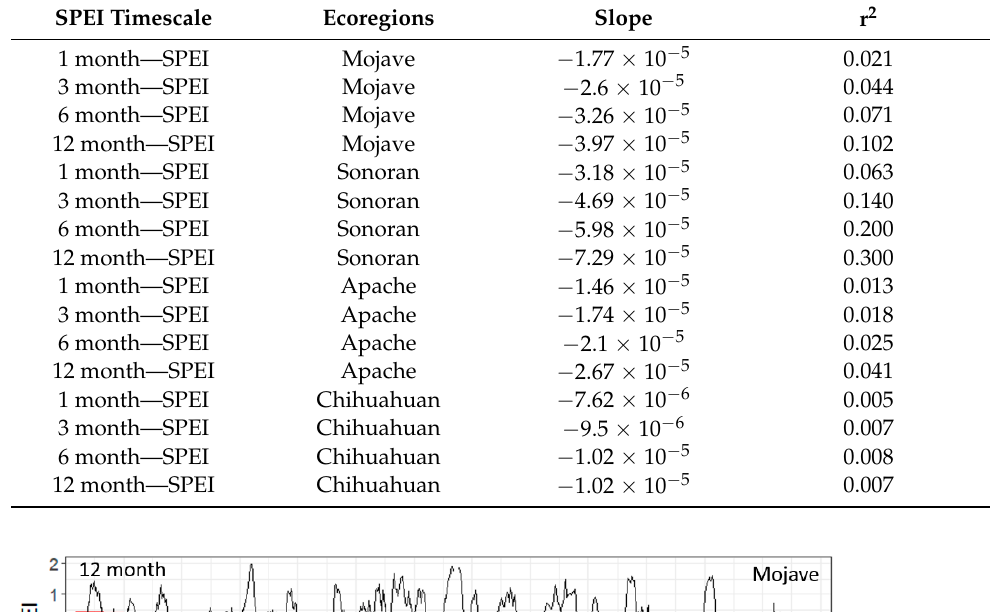
Table 1. The linear trend output of SPEI significant at p ≤ 0.05 from 1950 January to 2015 December for all ecoregions using the ecoregion scale SPEI data obtained from Global Drought Monitor [31].